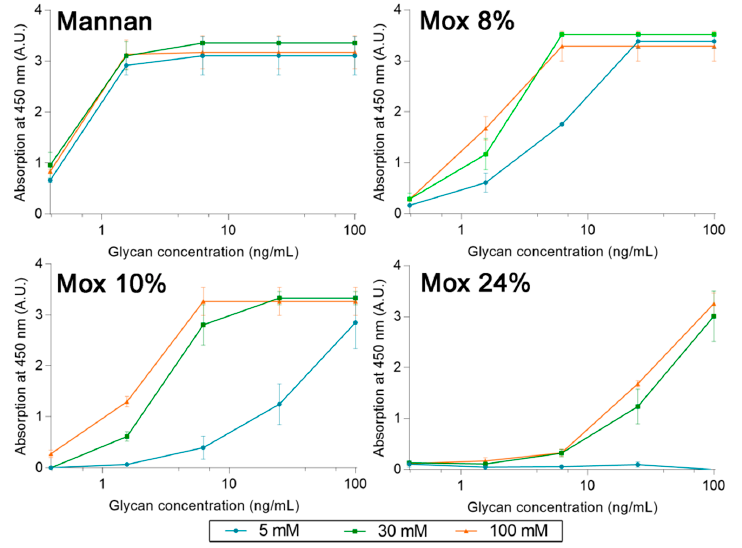
Figure 10. Avidities trends between Mannan , Mox , and human MBL, obtained using the protocol described before but with different concentrations of calcium chloride (5, 30, and 100 mM).